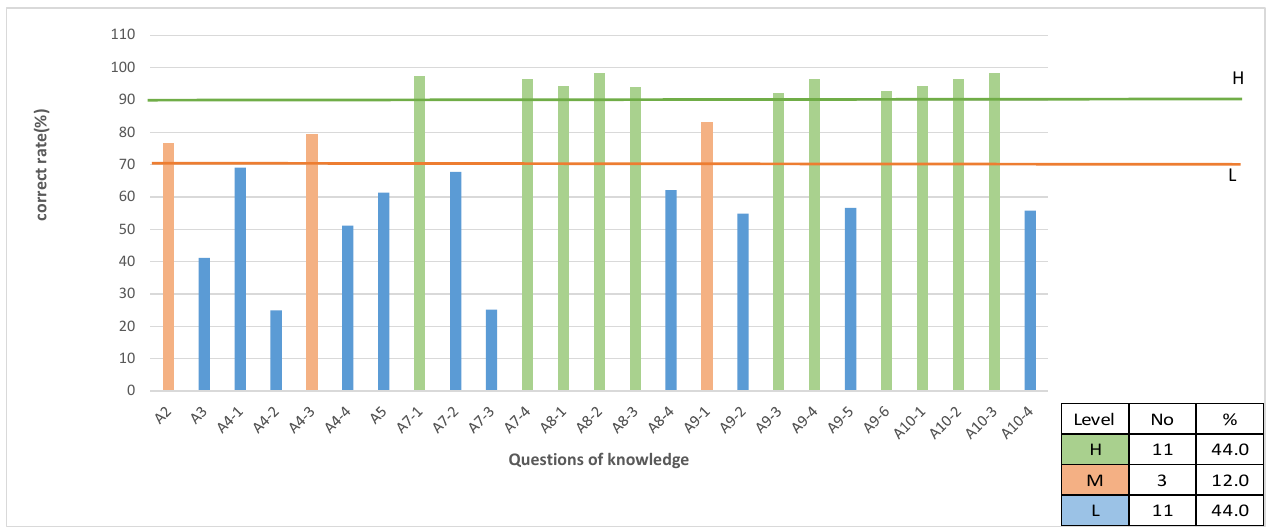
Figure 1. Correct answer rate of each question of knowledge regarding hand hygiene among nursing students. Level H, high (90% and over); M, medium (70–89%); L, low (69% and below).